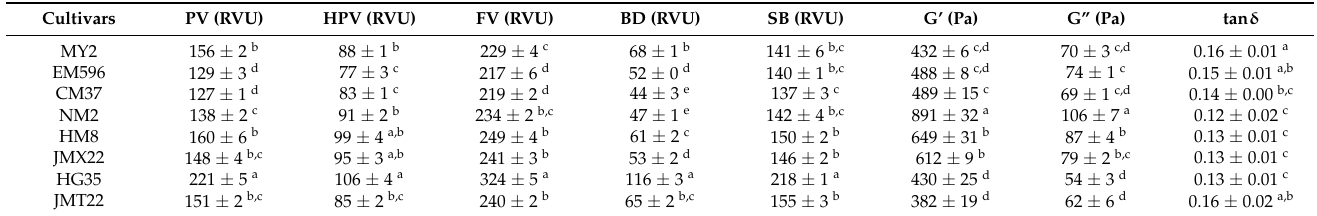
Table 4. Pasting and rheological properties of starch from wheat varying in grain hardness